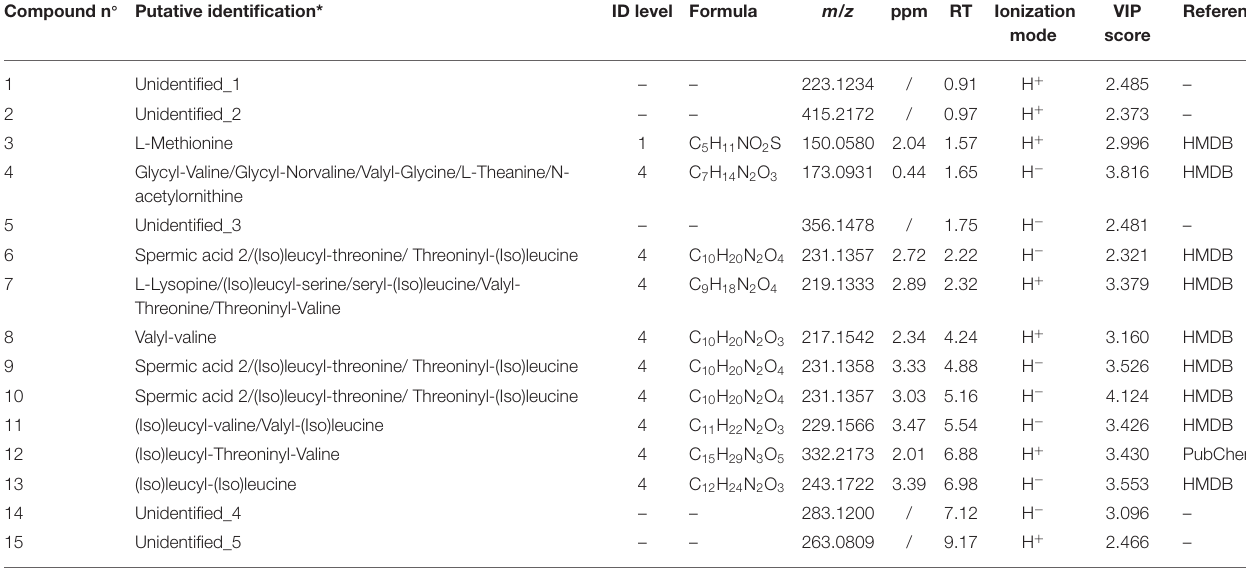
TABLE 3 | Overview of characteristics of L-methionine, putatively annotated and unidentified metabolite markers. Compound n ◦ Putative